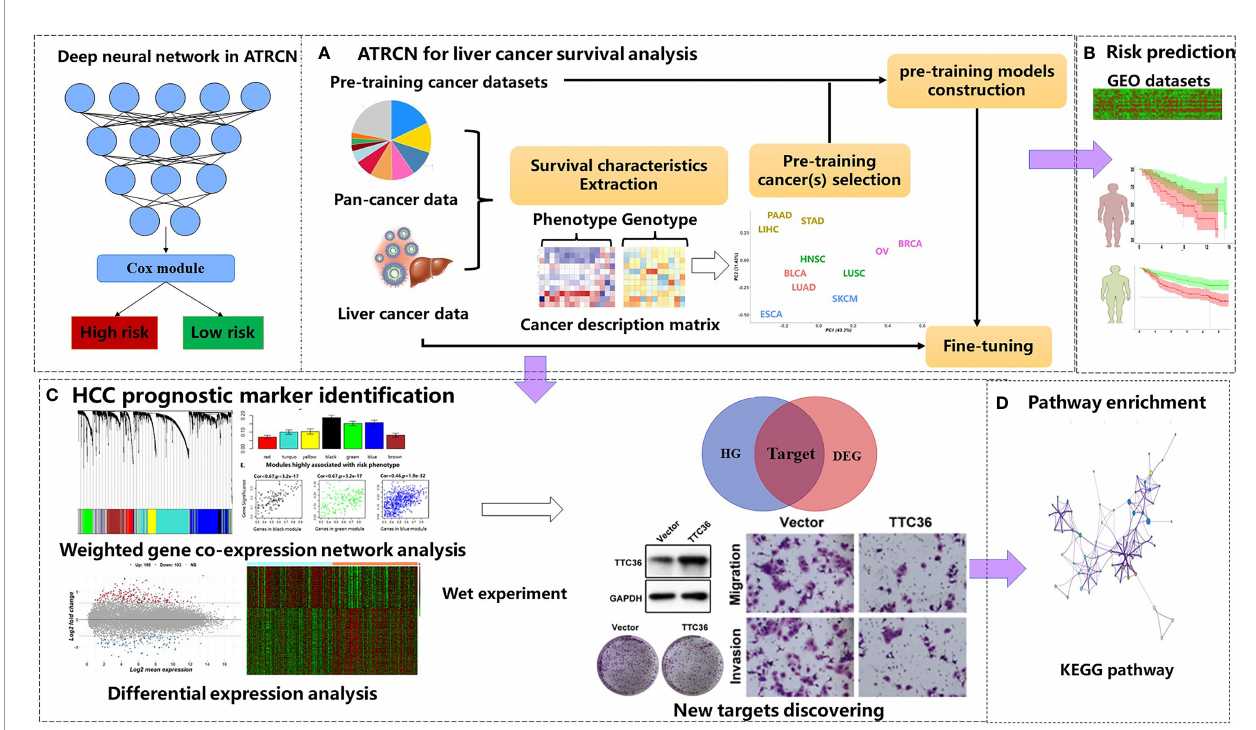
FIGURE 1 | Proposed adaptive transfer-learning-based deep Cox neural network (ATRCN) used for hepatocellular carcinoma (HCC) survival analysis. (A) Architecture of the proposed ATRCN. (B) Independent tests for the HCC prognosis prediction model obtained by ATRCN. (C) Identifying HCC prognostic markers. (D) Enriching the Kyoto Encyclopedia of Genes and Genomes (KEGG) pathways that are associated with HCC